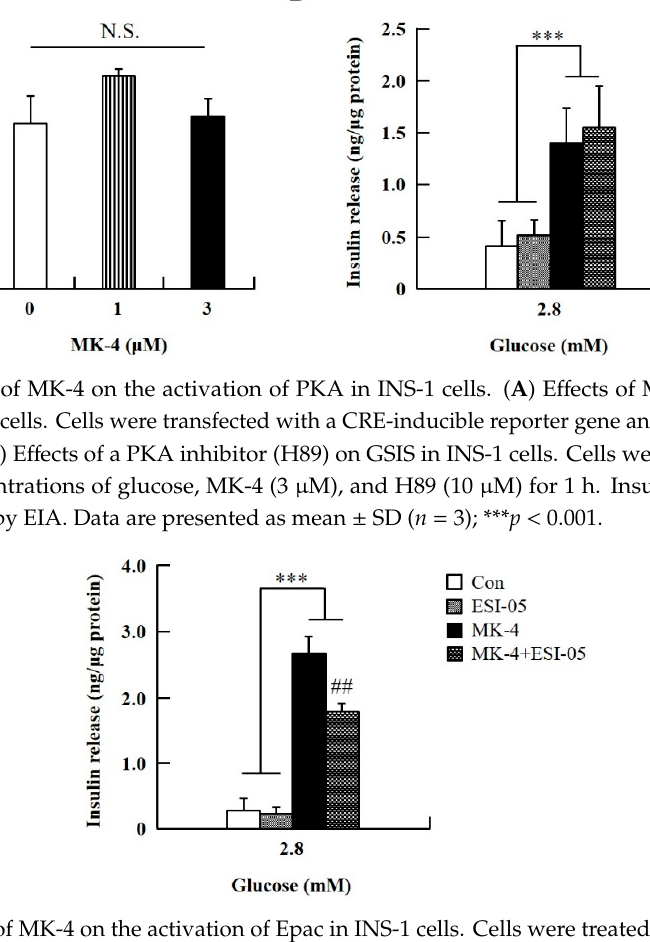
Figure 5. Effect of MK-4 on the activation of Epac in INS-1 cells. Cells were treated with the indicated concentrations of glucose, MK-4 (3 µM), and Epac2 inhibitor (ESI-05; 10 µM) for 1 h. Data are presented as mean ± SD ( n = 3); *** p < 0.001 vs. MK-4/MK-4+ESI-05, ## p < 0.001 vs. MK-4.